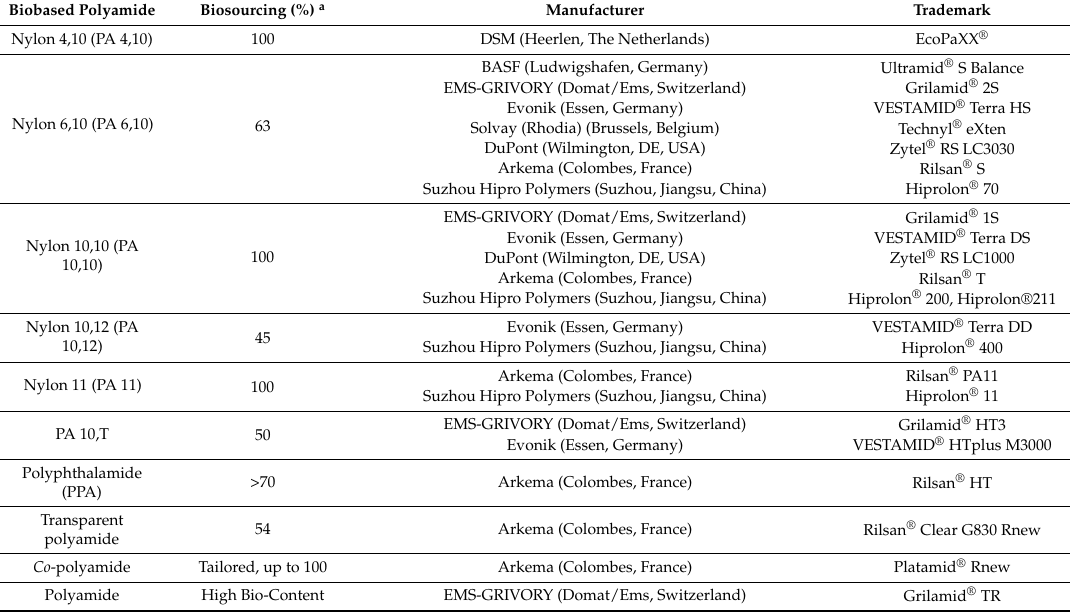
Table 2. A selected list of commercially available biobased polyamides and their manufacturers. Biobased